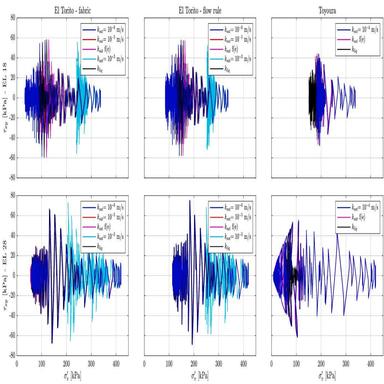
Stress paths in plane τ – σ′ v at elements 18 (top row) and 28 (bottom row) for both sands and calibrations.